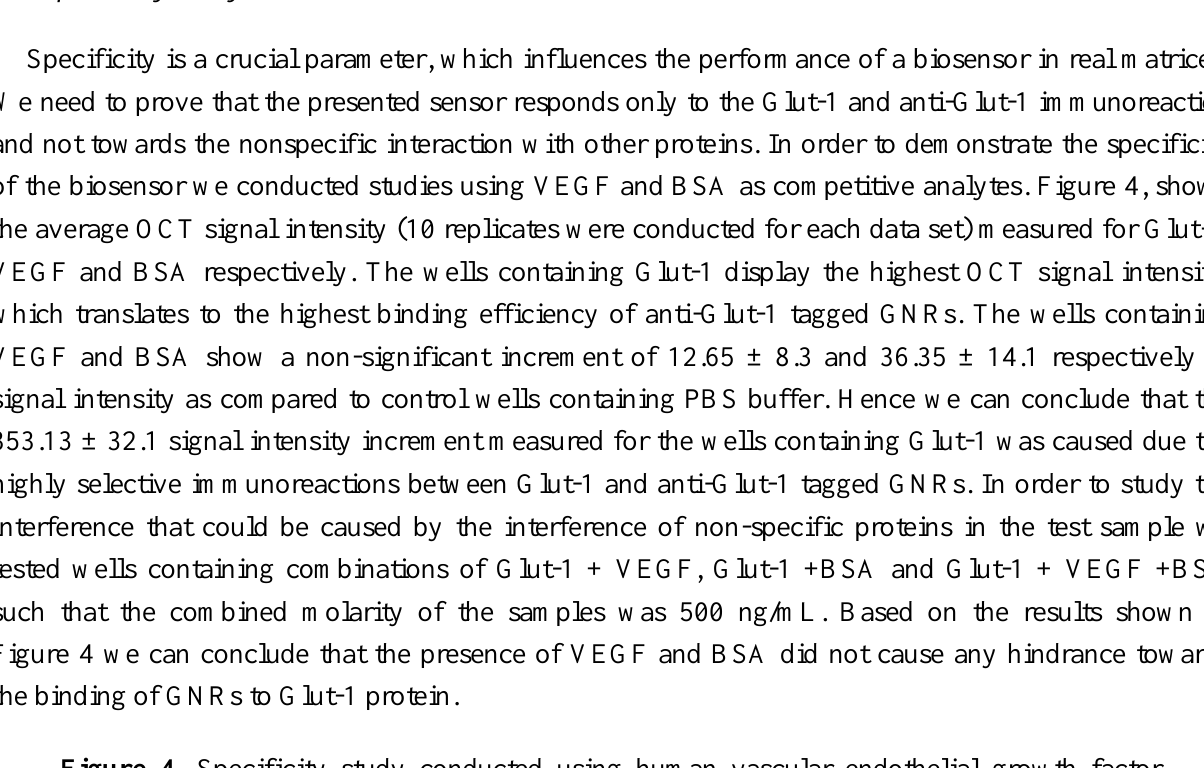
Figure 4. Specificity study conducted using human vascular endothelial growth factor (VEGF) and BSA as competitive analytes for anti-Glut-1 tagged gold